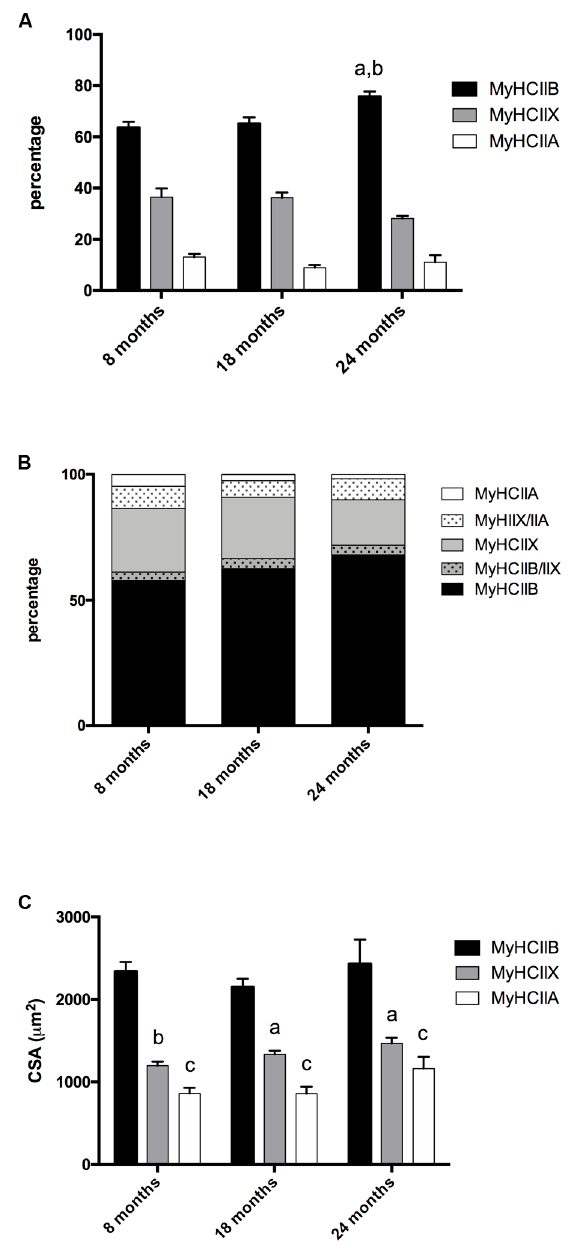
Figure1. Fiber-typecompositionandfiberCSAoftibialisanteriorduringageprogression. ( A )Fiber-type composition varies during age progression, the percentage of IIB fibers increases significantly in 24-month-old mice (a, significantly di ff erent from eight-month-old mice, p < 0.05; b, significantly di ff erent from 18-month-old mice, p < 0.05). ( B ) Percentage of pure and hybrid fibers during age progression. ( C ) The CSA is fiber-type-dependent and does not display major modifications during age progression (a, significantly di ff erent from age-matched type-IIB fibers, p < 0.01; b, significantly di ff erent from age matched type-IIB fibers, p < 0.001; c, significantly di ff erent from age matched type-IIB fibers, p < 0.0001). Data are reported as means ±